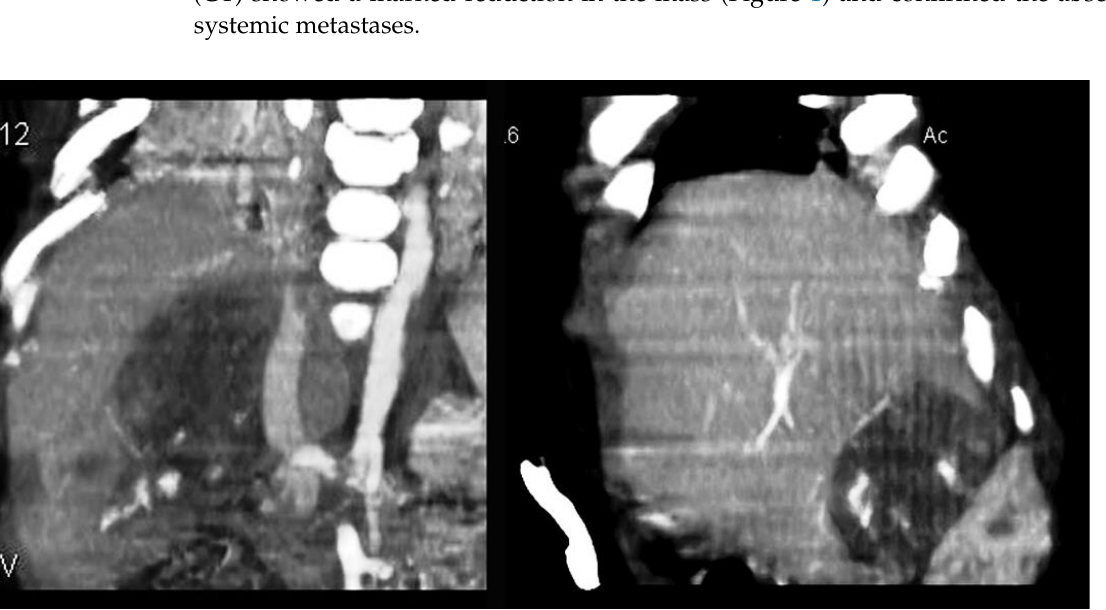
Figure 1. Legend — CT scan: marked reduction in the liver mass (image on the left before treatment) after chemotherapy (image on the right).